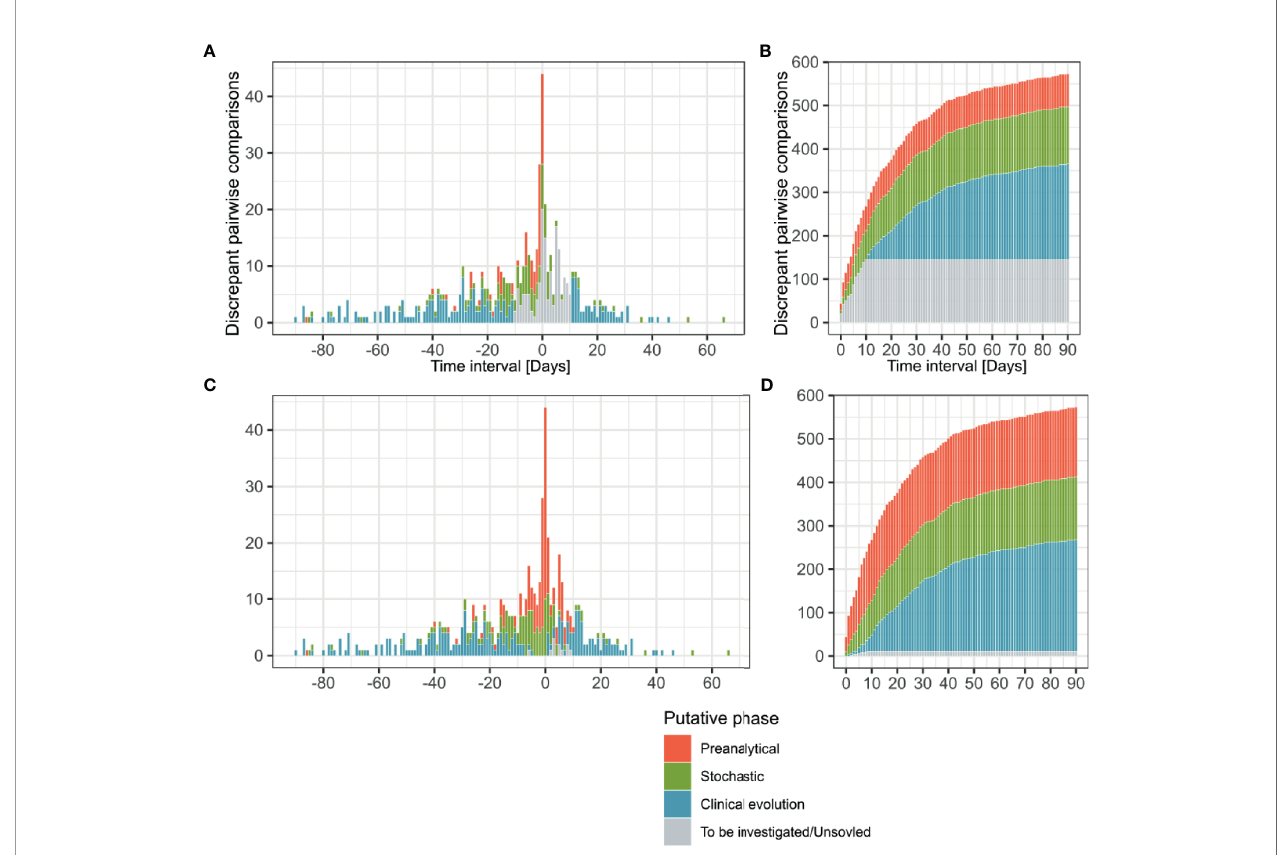
FIGURE 3 | Time interval between discrepant analyzes, putative phase assignment and cumulative curves. Pairwise comparisons (n = 573) are represented according to the interval between their reception dates and colored depending on the analytical phase which best explained the observed discrepancy. Before manual curation discrepancies were classi fi ed by the algorithm as “ Preanalytical ” , “ Stochastic ” , “ Clinical evolution ” and “ To be investigated ” (A, B) . After manual curation comparisons previously categorized as “ To be investigated ” were reassigned to the same categories or as “ Unsolved ” (C, D) . Transitions from a negative to a positive result are represented in the positive side of x axe, while positive to negative transitions are plotted on the negative side (A, C)